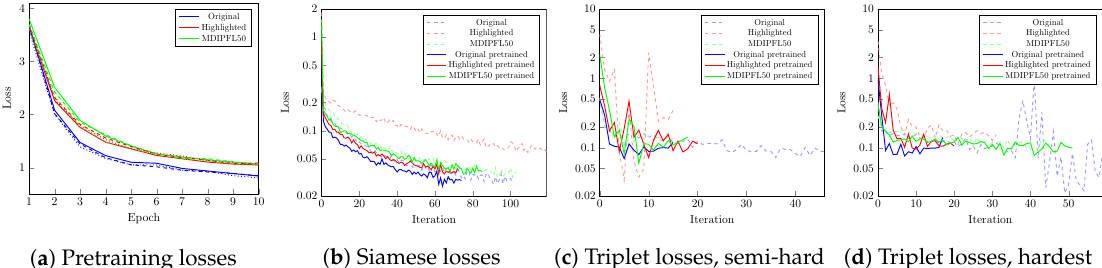
Figure 7. The evolution of loss during different phases of training. Subfigure ( a ) illustrates the measured pretraining loss for the three different inputs and models. ( b ) visualizes the measured loss on Siamese structured training, while ( c , d ) shows the change of triplet loss over training iterations for semi-hard and hardest negative selection, respectively. It is notable, that ( b – d ) use a logarithmic vertical scale for a more detailed